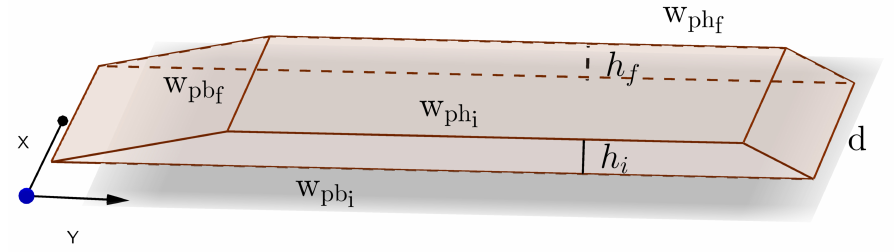
Figure 3. Elementary earthmoving Volume, X is the longitudinal direction, Y is the transverse direction by